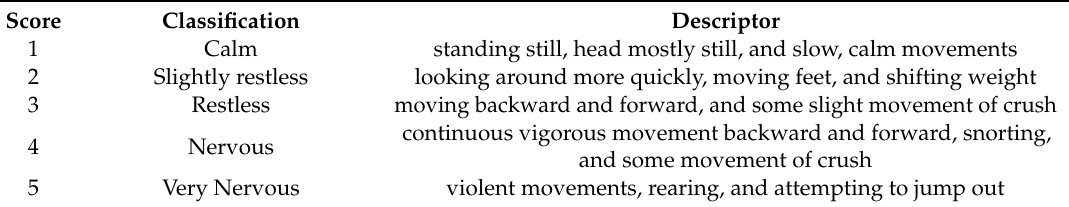
Table 1. Cattle crush scoring descriptions 1